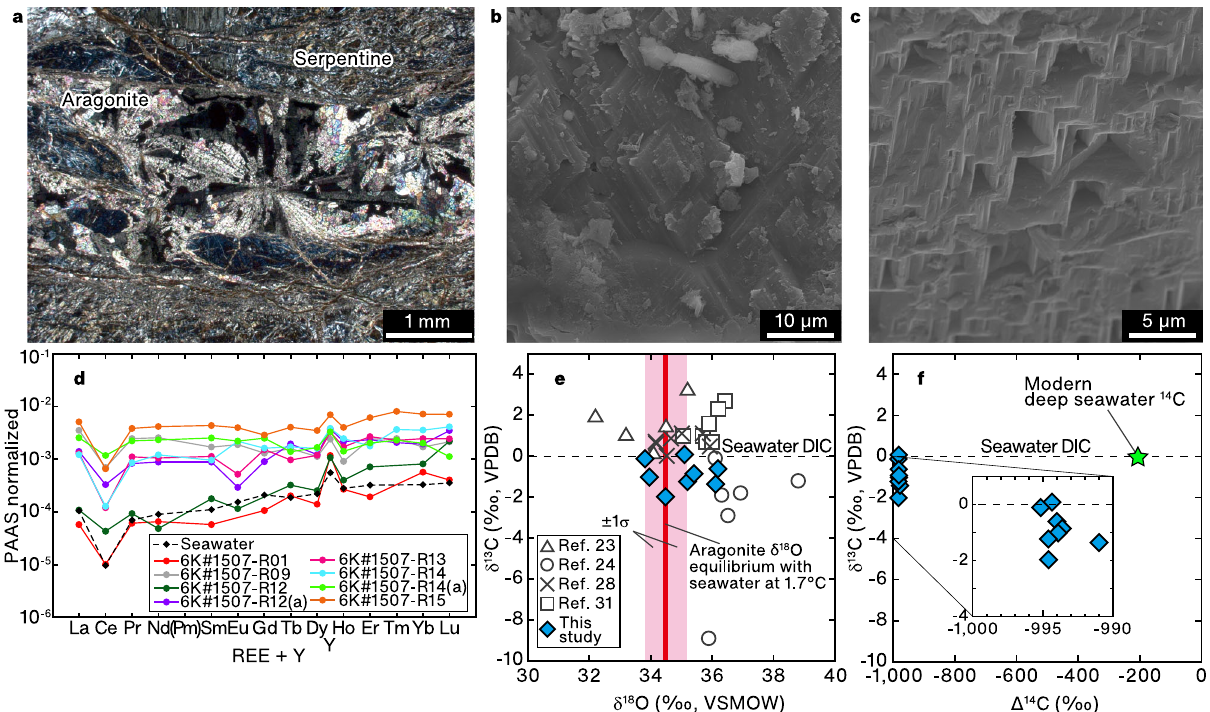
Fig. 3 Mineralogical and geochemical characteristics of the studied aragonite. a Radiating aragonite that in fi lls between brecciated serpentinite clasts. SEM image of aragonite surface showing growth banding ( b ) and dissolution etch pits ( c ) in a single aragonite crystal. d Selected REE + Y (REY) patterns of the aragonite samples. e A comparison of C and O isotope data of this study with those of serpentine-hosted carbonate collected during previous dredges and dives. Data for aragonite-bearing serpentinized peridotite recovered from hydrothermal fi elds are from Eickman et al. 31 (Logachev and Gakkei ridges; 2000 – 4000 mbsl) and Ribeiro et al. 28 (Rainbow and Saldanha fi elds; 2200 mbsl). Aragonite in serpentinized peridotite from the IOT is characterized by negative δ 13 C values. Negative δ 13 C values have been reported from the Mariana Trough 24 , where cold and methane-rich seeps are observed. The red line and pink region indicate the δ 18 O V-SMOW value and ±1 σ range (34.5 ‰ ± 0.7 ‰ ) that is in equilibrium with seawater ( δ 18 O V-SMOW = 0 ‰ ) at 1.7 °C. f Relationship between Δ 14 C and δ 13 C of aragonite. The modern deep seawater Δ 14 C value of DIC ( − 200 ‰ to − 210 ‰ ) 42 is represented by the green star. The inserted graph is a close-up view of the data. The analytical errors in e and f are substantially smaller than the symbols (Supplementary Table